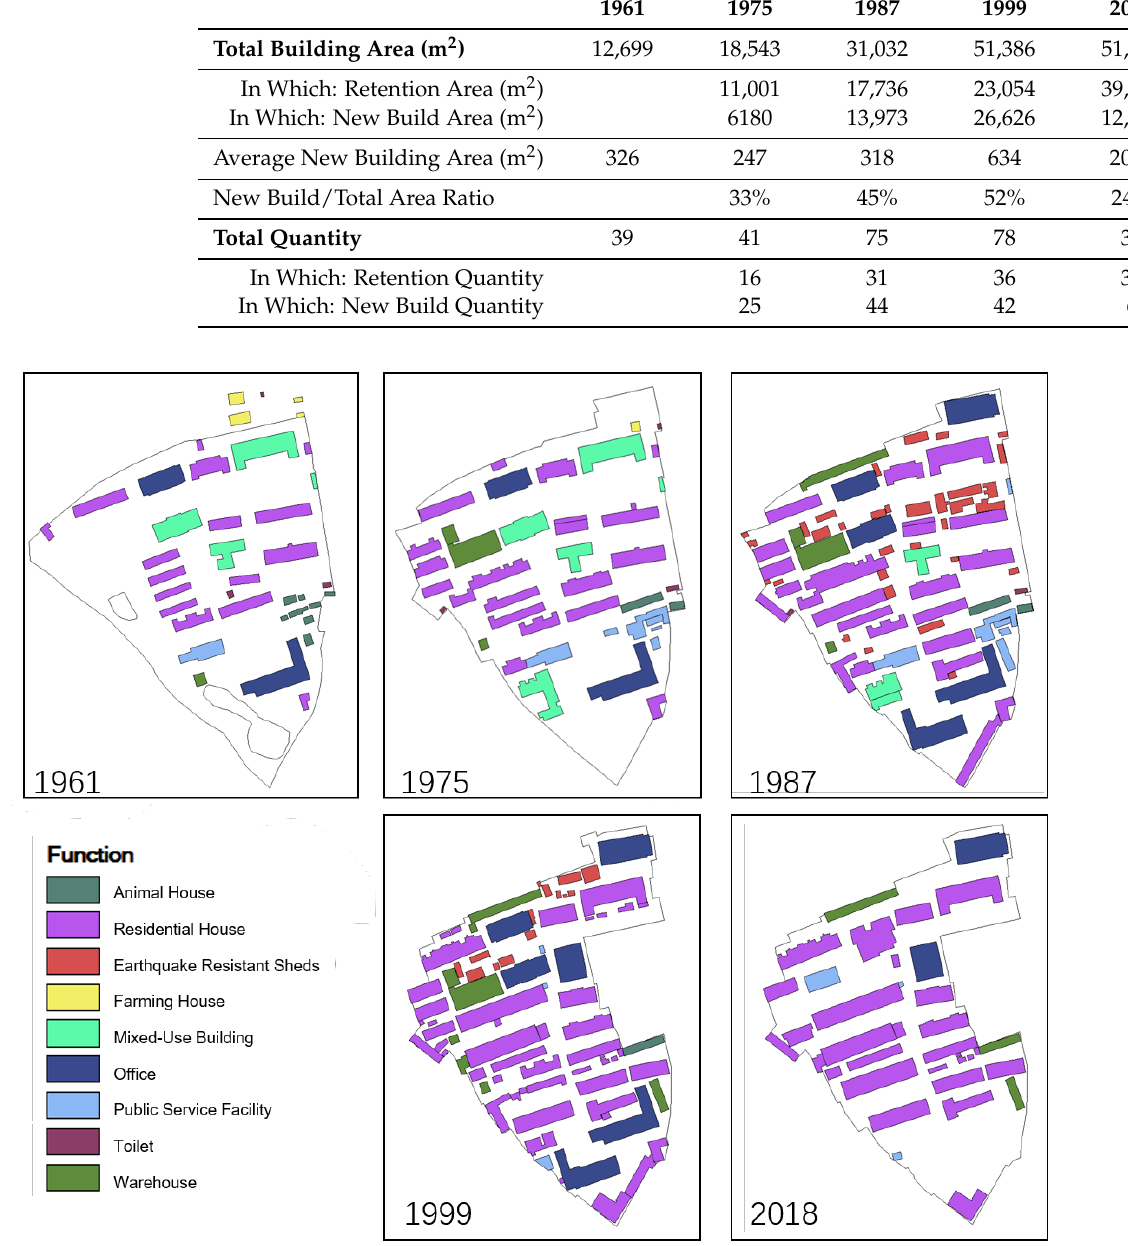
Figure 11. Building function map of the AMS